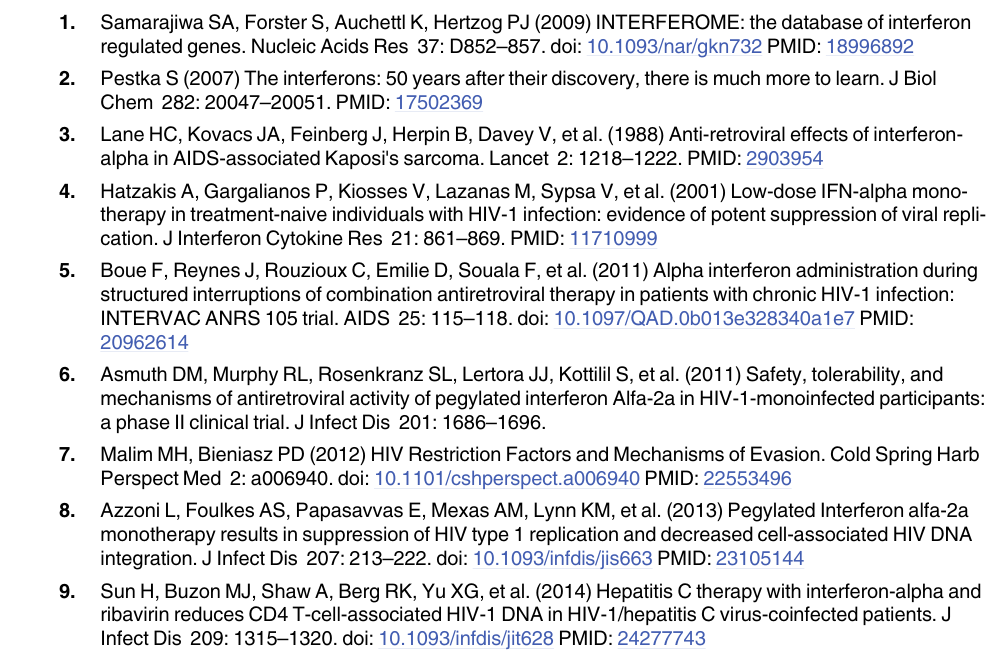
S6 Fig. A3F and A3D expression in the presence of IFN α subtypes. LPMCs (n = 3 donors) were thawed and infected with HIV-1 , then treated with 100 pg/ml of weak (gray bars) and BaL potent (black bars) IFN α subtypes. IFN α 1, IFN α 2, IFN α 8 and IFN α 14 shown simply as 1, 2, 8 and 14. After 24 hr, CD4+ T cells were negatively selected and RNA extracted for qPCR. A3F and A3D were quantified using Taqman qPCR normalized to GAPDH levels. Mean fold- induction values are shown for the 3 donors. S1 Table. Primers and probes for ISG